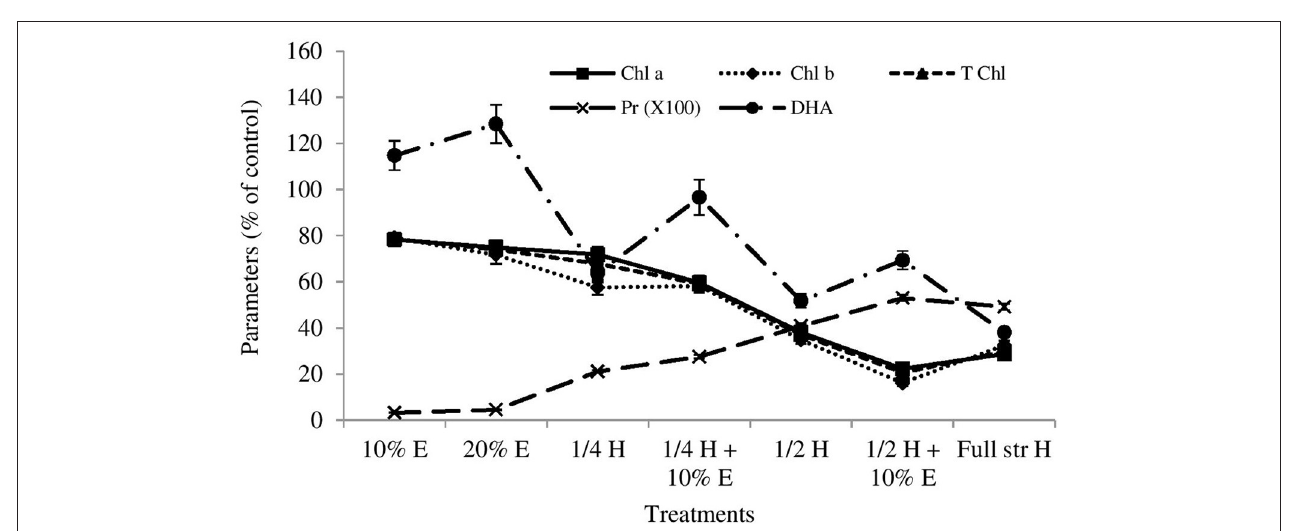
FIGURE 4 | Effects of boneseed extracts, herbicide and mixture on post-emergent ryegrass (21 days after spray). The x-axis denotes the treatment types (10% aqueous extract of boneseed leaf, 20% extract, ¼ strength herbicide, mixture of ¼ strength herbicide with 10% extract, ½ strength herbicide, mixture of ½ strength herbicide with 10% extract and full-strength herbicide). Values on y-axis denote the impact (% of control) on chlorophyll a (chl a) (solid line with square marker), chlorophyll b (chl b) (round dot line with diamond marker), total chlorophyll (T chl) (square dot line with triangular marker) and proline (pro) (long dash line with circle marker) content of ryegrass, and soil dehydrogenase activities (DHA) (long dash dot dot line with cross marker). The error bar indicates the standard